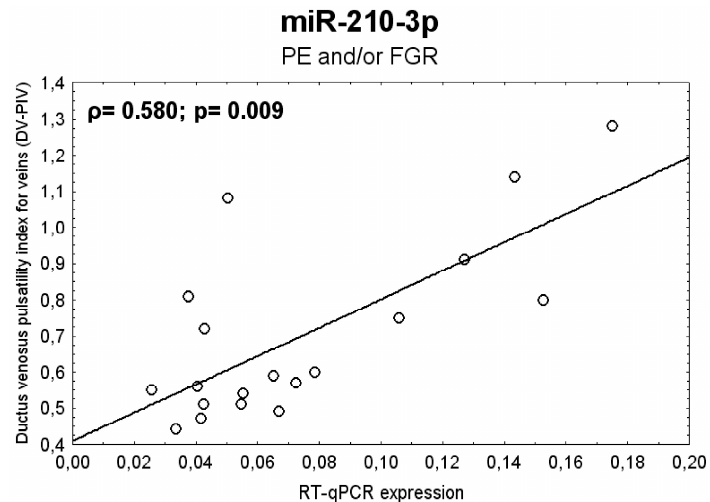
Figure 17. Association between postnatal miR-210-3p expression and the pulsatility index in the ductus venosus in PE and/or FGR patients. The pulsatility index in the ductus venosus showed a strong positive correlation with miR-210-3p gene expression in patients with a history of PE and/or FGR.